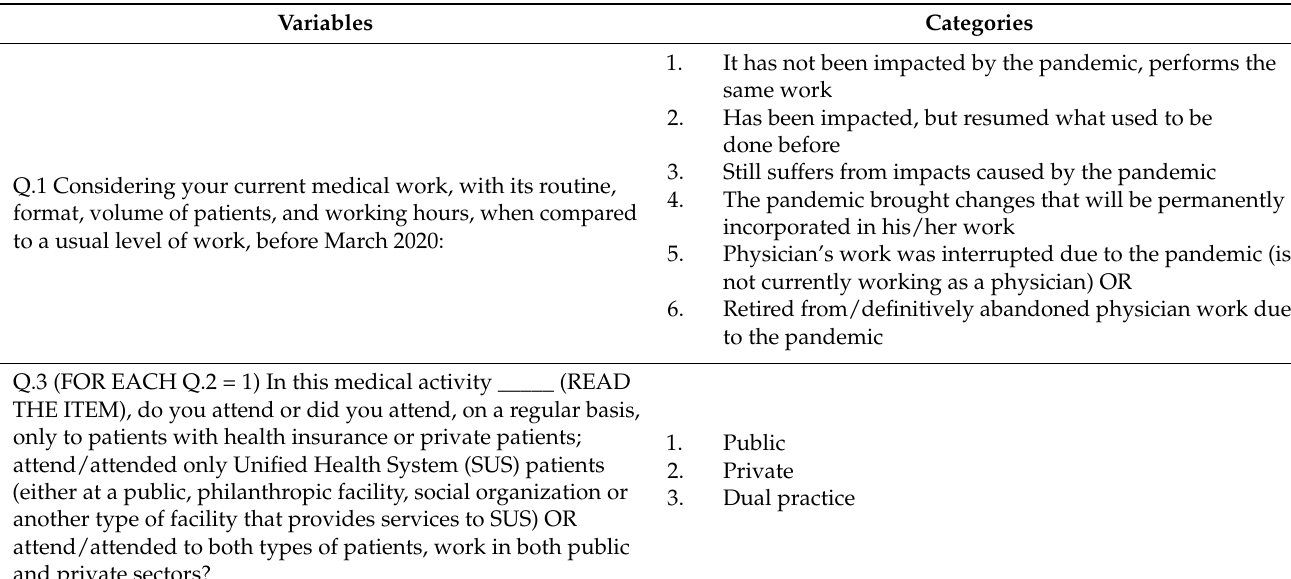
Table 1. Variables and their categories investigated among physicians interviewed in the Survey on the Labor Market and Impact of the New Coronavirus in SP and MA, Brazil,